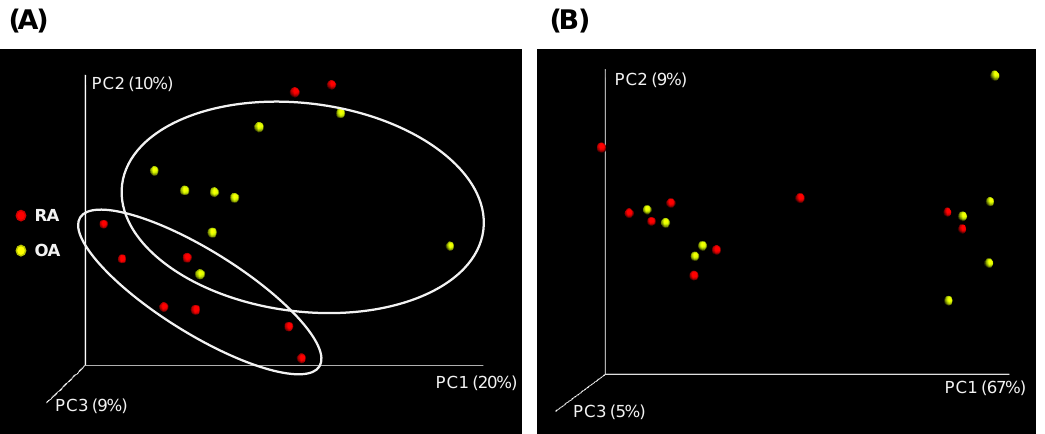
Figure 3. Three-dimensional diagram of the principal coordinate analysis (PCoA) of ( A ) unweighted UniFrac and ( B ) weighted UniFrac distance metrics of the OTUs abundance data from the fecal sample of rheumatoid arthritis (RA) and osteoarthritis (OA) patients. 3.3. Relative Abundances of Bacterial Taxa at Di ff erent Taxonomic Levels Between RA and OA Patients The relative abundance of the OTUs, classified as phylum, class, family, and species levels, for each individual sample in the RA and OA groups are shown in the stacked bars in Figures 4 and